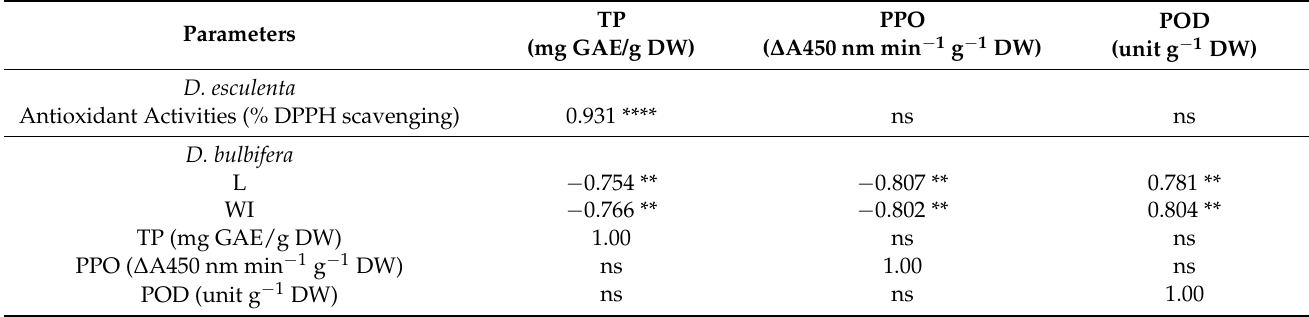
Table 6. The correlation coefficient (r) between parameters of yam